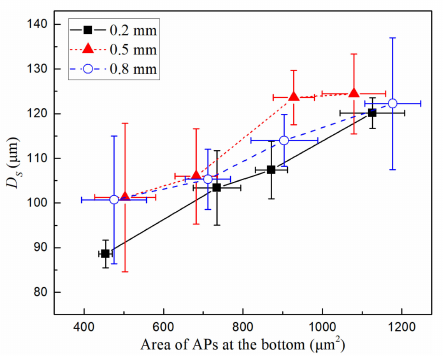
Figure 5. The relationship between D S and the area of APs at the bottom in the tubes with different diameters. Starting from 400 µ m 2 , a group of data in the range of every 200 µ m 2 was obtained for this graph. P = 189